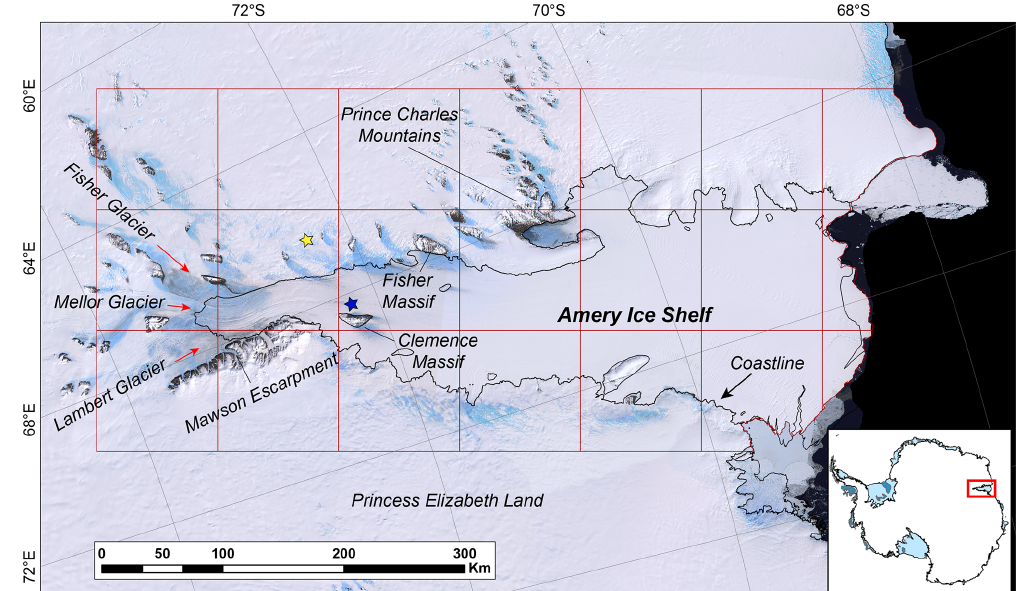
Figure 1. Study region over the Amery Ice Shelf, including an inset showing its location within Antarctica. The background image is the Landsat Image Mosaic of Antarctica (LIMA). The red boxes indicate the area over which melt was mapped, with tiles representing 21 separate 100km by 100km regions of interest (ROIs) for mapping within GEE. The black line marks the coastline from the SCAR Antarctic Digital Database (Gerrish et al., 2021). Red arrows indicate the flow direction of labelled outlet glaciers. The blue and yellow stars represent the location of Fig. 5a/c and b respectively.